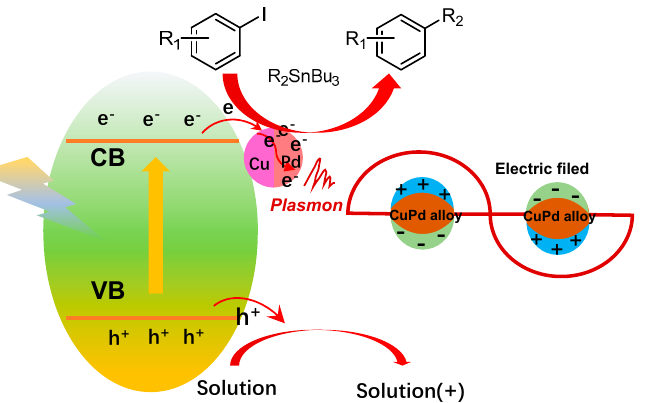
Figure 5. Proposed mechanism responsible for the photocatalytic Stille coupling reaction over CPT-1.5.